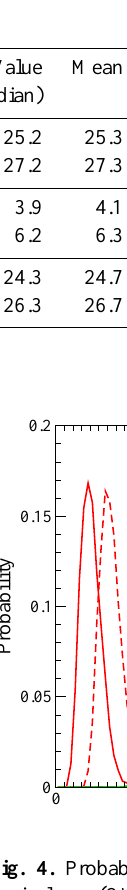
Table 2. Minimum, maximum, central values, mean, standard deviation, 1–99% and 5–95% uncertainty ranges for the 100-yr GWP, 100-yr GTP and GDP.